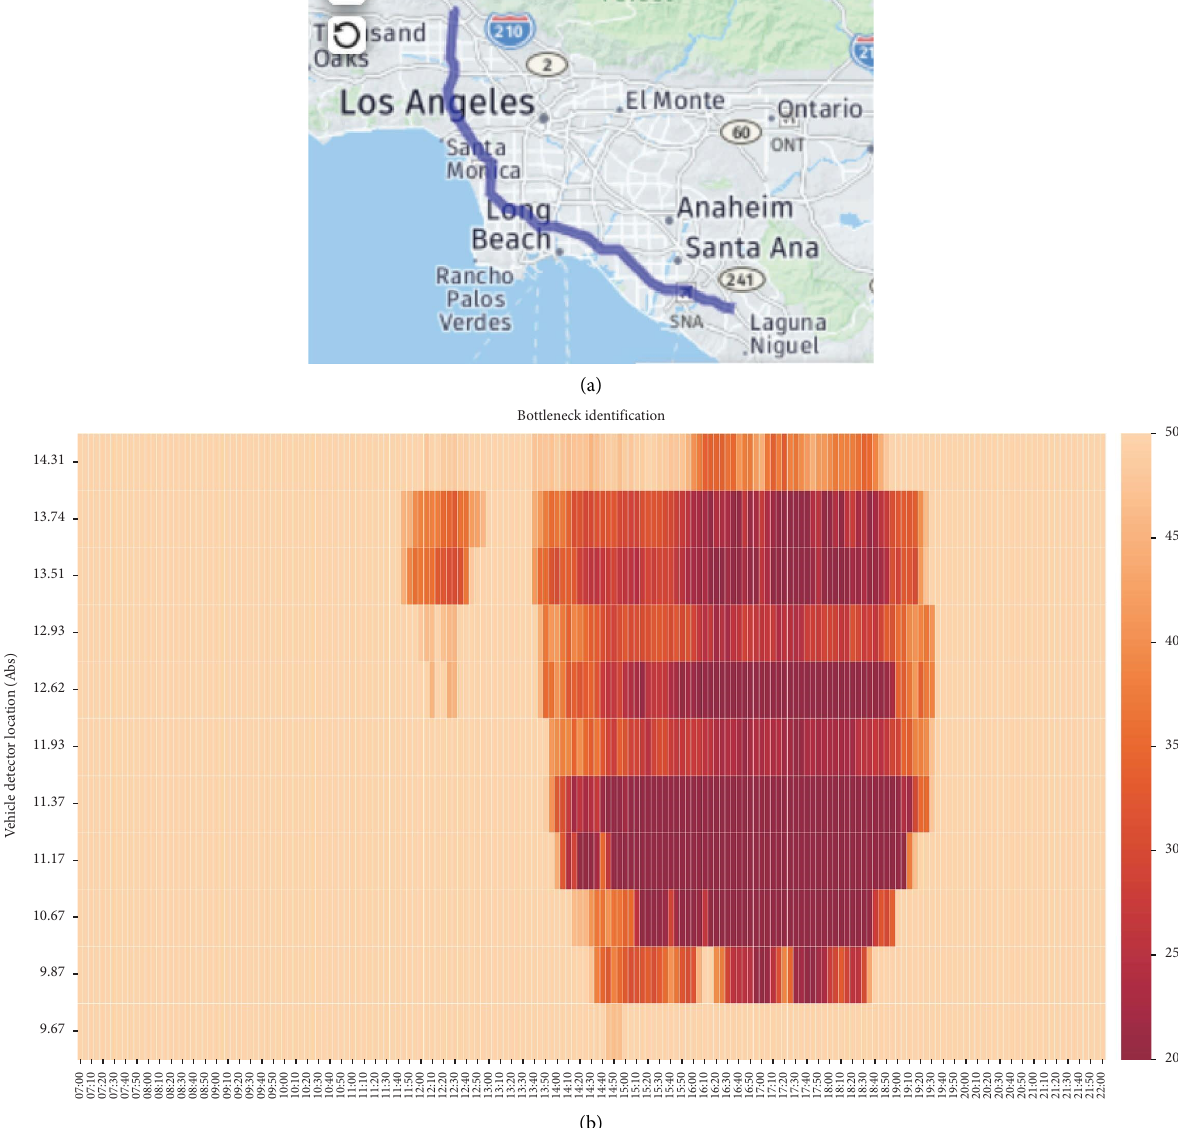
Figure 5: Data acquisition. (a) Freeway segment location. (b) Bottleneck